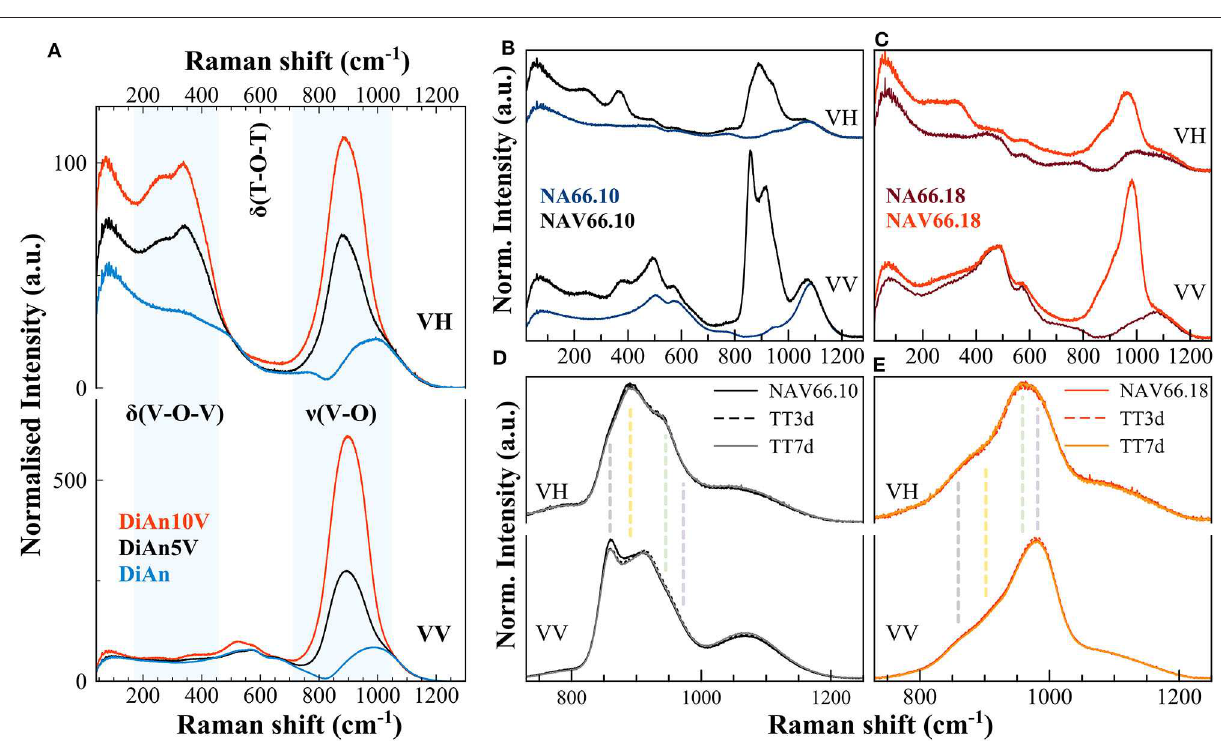
Figure 7A ). In the low-frequency region ( ∼ 150–500 cm − 1 )